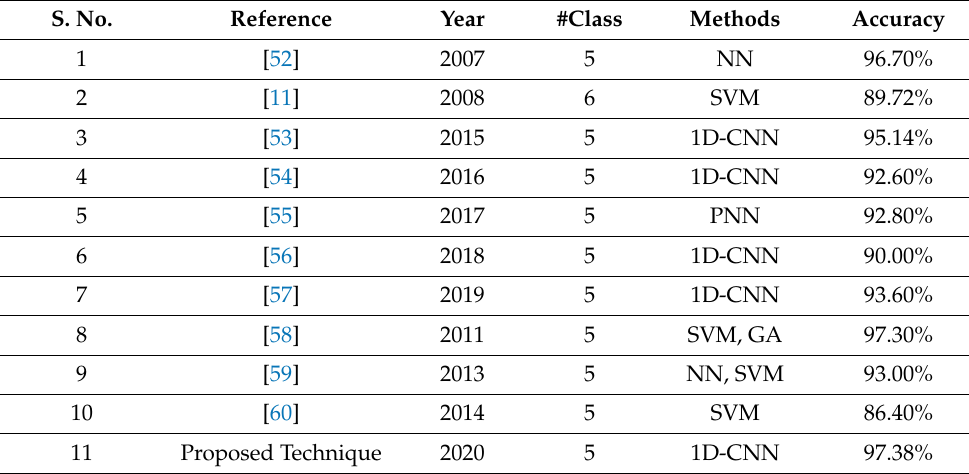
Table 3. Comparison with other state-of-the-art algorithms. The proposed method is compared with different approaches on the same benchmark dataset (MIT-BIH arrhythmia database). S.